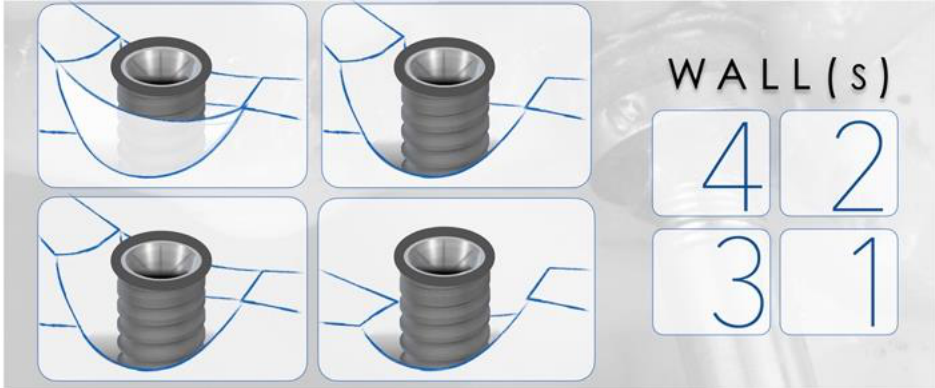
Figure 3. Representation of peri-implant defects according to the number of walls surrounding the lesion. The right panel corresponds to the number of walls present in the representations. The higher the number of walls, the higher is the positive outcomes of regenerative therapy.